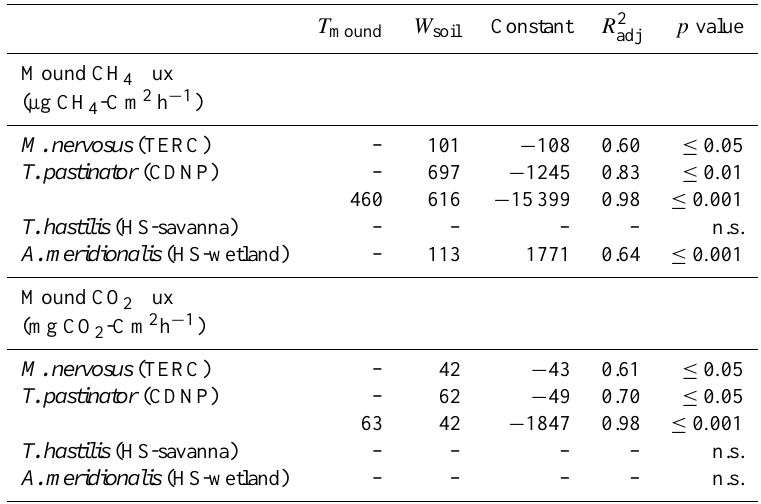
Table 3. Significant linear regression models of mound CH 4 and CO 2 fluxes with mound temperature ( T mound in ◦ C) and gravimetric soil water content ( W soil in %) as determined by single factor and multiple linear regression procedure for individual termite species.